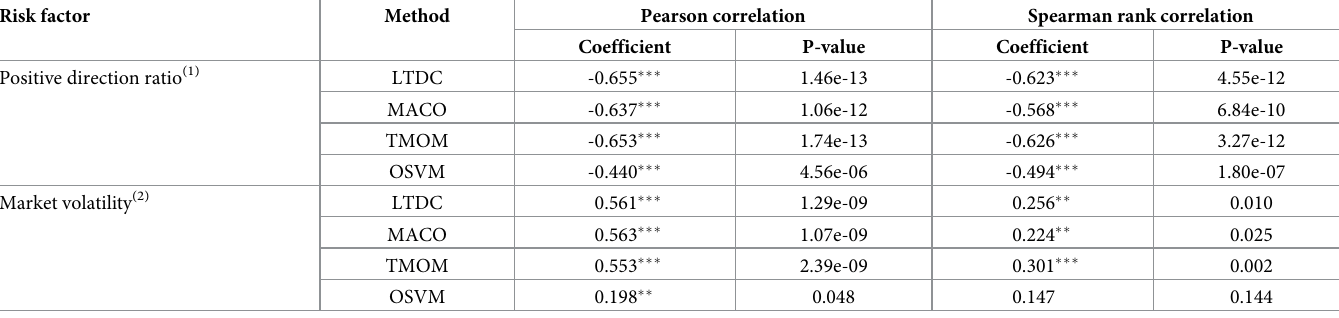
Table 4. Pearson and Spearman rank correlations between risk factors and excess returns averaged over all d L